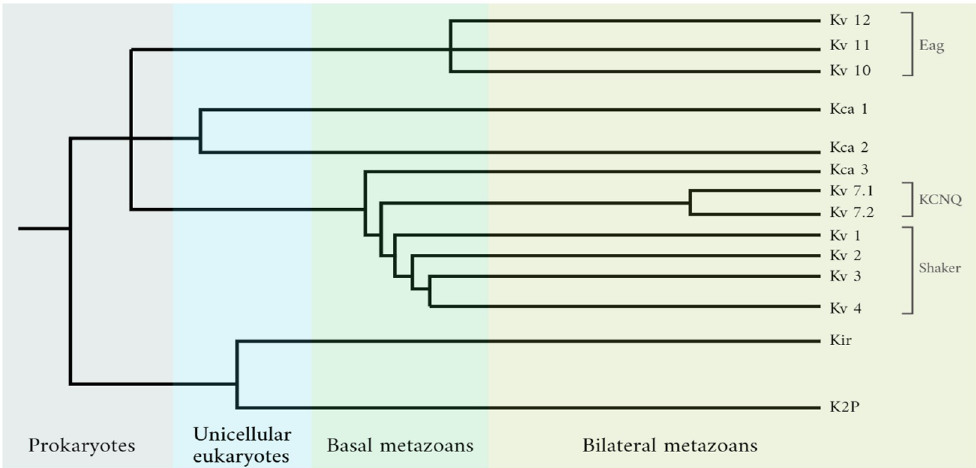
Fig 5. Evolution of potassium-specific ion channels during the time of appearance of 4 groups of organisms. Data taken from Li et al. [35]. Kv channel families are indicated. Unicellular eukaryotes refer specifically to the choanoflagellates. Basal metazoans include Ctenophora (comb jellies) and Cnidaria (jellyfish, sea anemones, and corals). Branch length is not proportional to time.